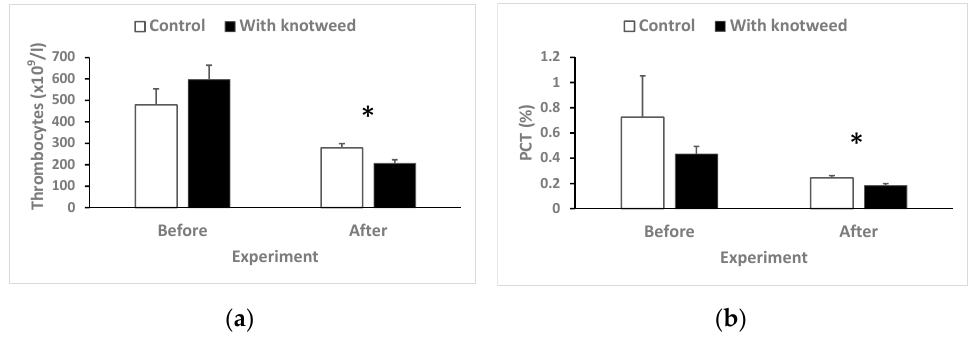
Figure 12. Thrombocytes ( a ) and PCT ( b ) in all animals at the beginning and the end of the experiment